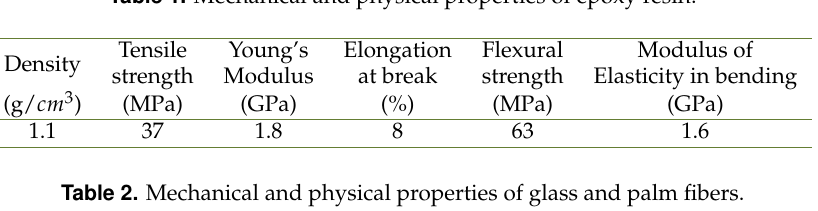
Table 1. Mechanical and physical properties of epoxy resin.